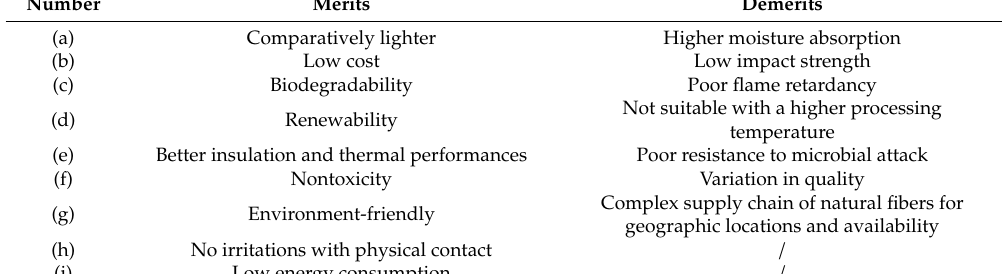
Table 1. A brief summary on the merits and demerits of biofiber-reinforced biocomposites (BCs) and NBCs over traditional petroleum-based composites [11].